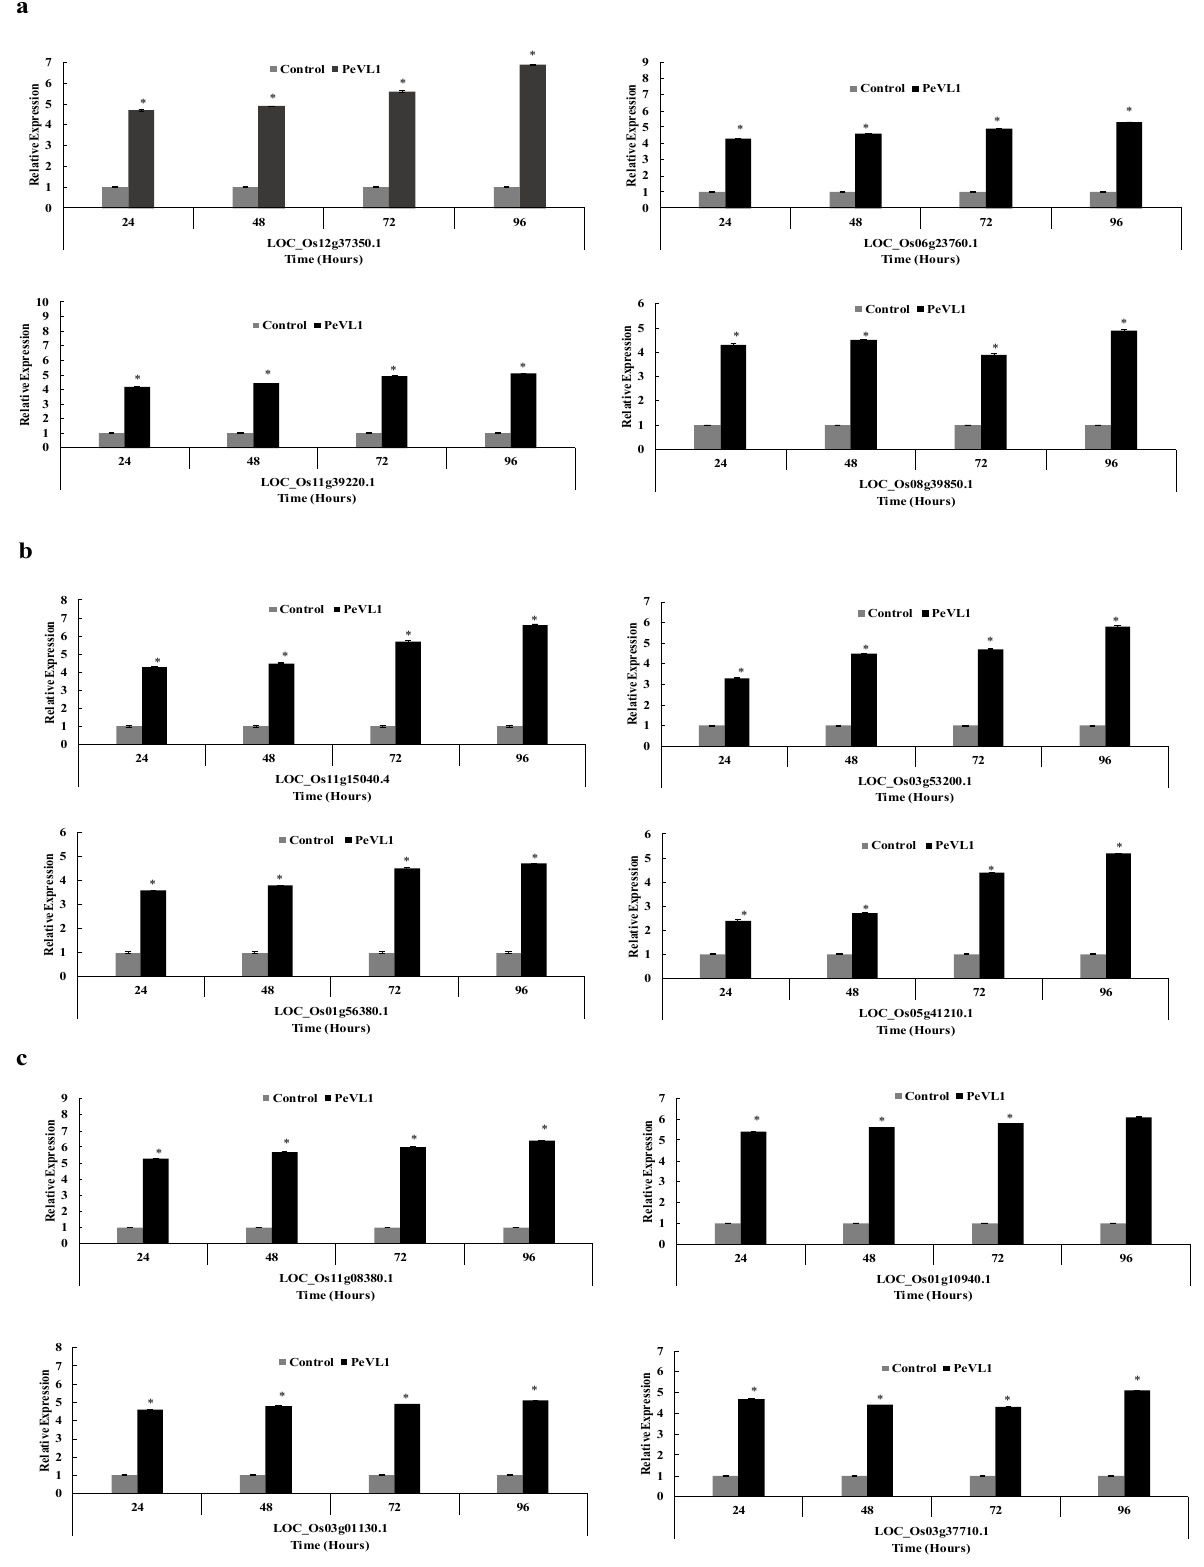
Figure 7. After PeVL1 elicitor treatment and M. ruralis infestation, the relative expression of plant defense from the JA, SA and ET pathway, i.e., ( a – c ), respectively, was detected. An asterisk next to each gene indicates a significant difference from the buffer control, as determined using Student’s t -test ( p <